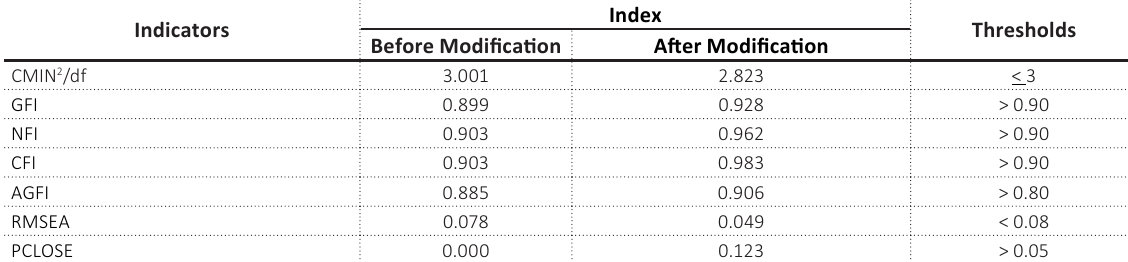
Table 1. Confirmatory factor analysis and model fit